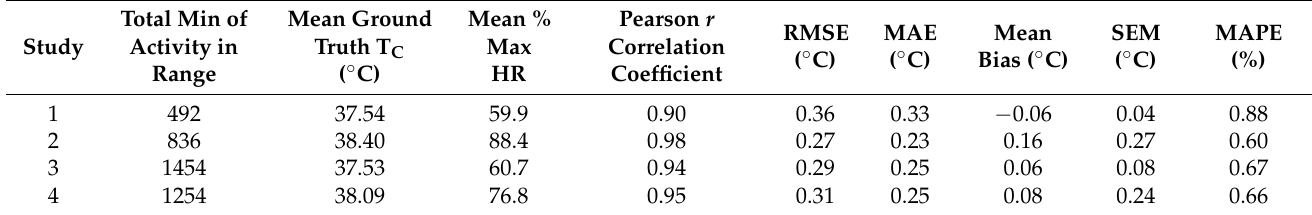
Table 2. Kenzen T C algorithm accuracy for Studies 1–4.